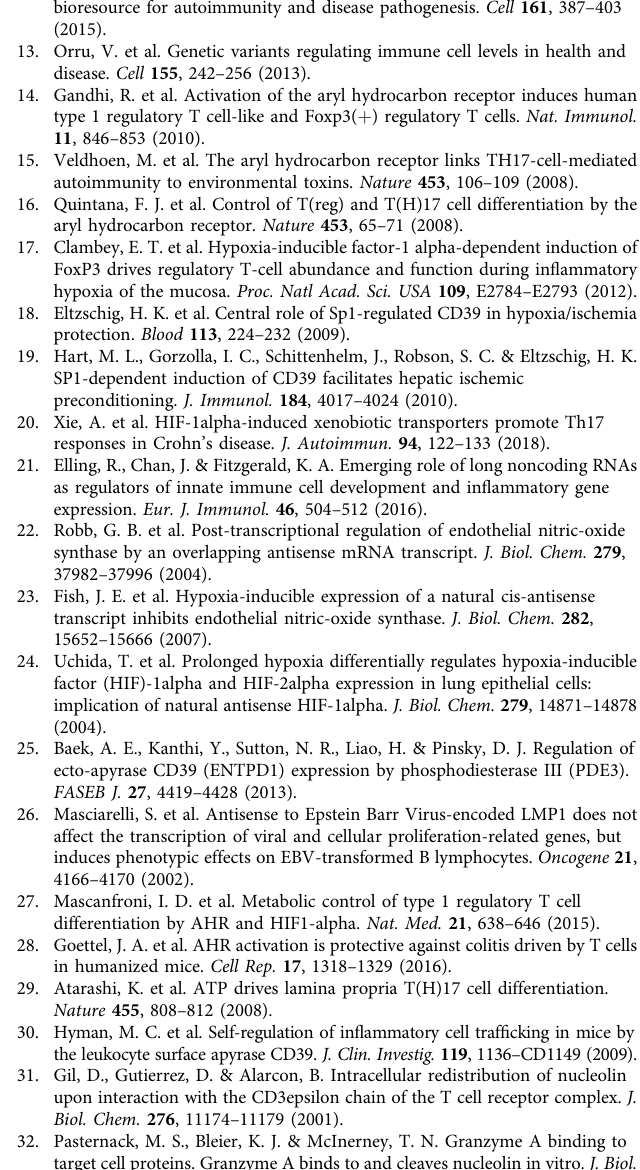
Fig. 6 Silencing of NCL alone or in combination with HNRNPA1 boosts CD39 levels in Crohn ’ s derived Treg and Th17 cells. Nuclear and cytoplasmic subcellular fractions were obtained from Treg and Th17 cells and tested for antisense expression. a , b Mean ± SEM CD39-AS RNA levels in Treg and Th17 cells from HS ( n = 7) and Crohn ’ s disease patients ( n = 12) ( a ** P = 0.008 for HS and * P = 0.01 for Crohn ’ s patients; b * P = 0.01 for HS and ** P = 0.009 for Crohn ’ s patients using two-sided unpaired t test). Based on the results of mass spectrometry, Treg and Th17 cells, differentiated from the peripheral blood of healthy subjects and Crohn ’ s disease patients, were exposed to scramble or gene-speci fi c siRNA. c , d Mean± SEM CD39 and CD39-AS RNA levels and CD39 MFI in untreated and siRNA (or scramble) treated Treg and Th17 cells from healthy subjects (HS; Treg: CD39 mRNA n = 6; CD39-A S RNA n = 5; CD39 MFI n = 10; Th17: CD39 mRNA n = 6; CD39-AS RNA n = 7; CD39 MFI n = 10) and Crohn ’ s disease patients (Treg: CD39 mRNA n = 6; CD39-A S RNA n = 4; CD39 MFI n = 6; Th17: CD39 mRNA n = 5; CD39-AS RNA n = 4; CD39 MFI n = 6) ( c * P = 0.038, ** P = 0.002, # P = 0.04, ## P = 0.006 for CD39 mRNA and * P = 0.04 for CD39MFI; d * P = 0.049, ** P = 0.0028, # P = 0.012, ¶ P = 0.01 for CD39 mRNA and * P = 0.049, ** P = 0.009, # P = 0.018, ¶ P = 0.011 for CD39 MFI using one-way ANOVA followed by Tukey ’ s multiple comparisons test). Silencing of NCL, alone or in combination with HNRNPA1, resulted in increased CD39 mRNA levels and MFI in Treg and Th17 cells obtained from Crohn ’ s patients. e Mean± SEM percentage inhibition of CD4 + CD25 − cell proliferation in the presence of untreated and siRNA (or scramble) treated Treg in HS ( n = 7) and Crohn ’ s disease patients ( n = 7) (* P = 0.029, # P = 0.032, ¶ P = 0.014, and ƒ P = 0.037 using one-way ANOVA followed by Tukey ’ s multiple comparisons test). Silencing of NCL, HNRNPA1, or both enhanced the suppressive function of Treg obtained from patients with Crohn ’